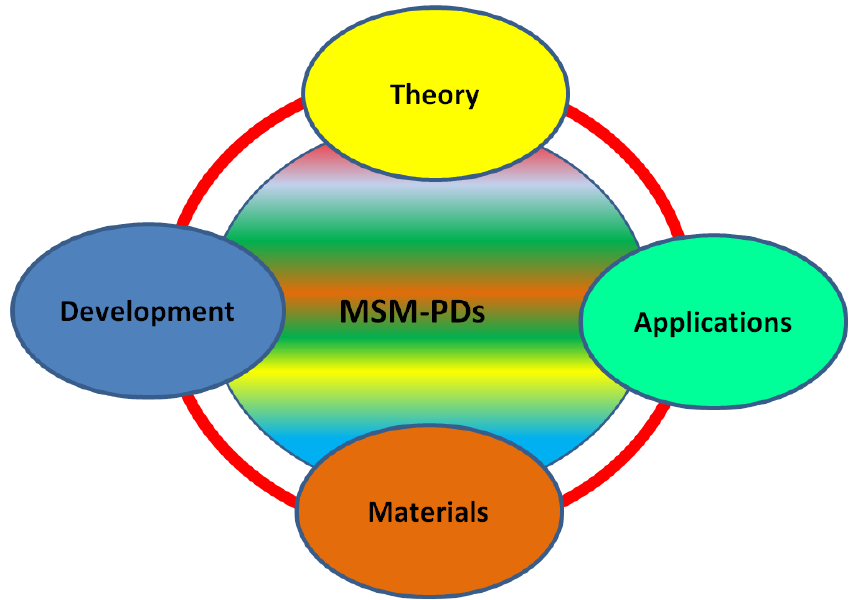
Figure 2. Schematic diagram that presents the relevant sections that are required to be focused on to complete the MSM-PDs study.